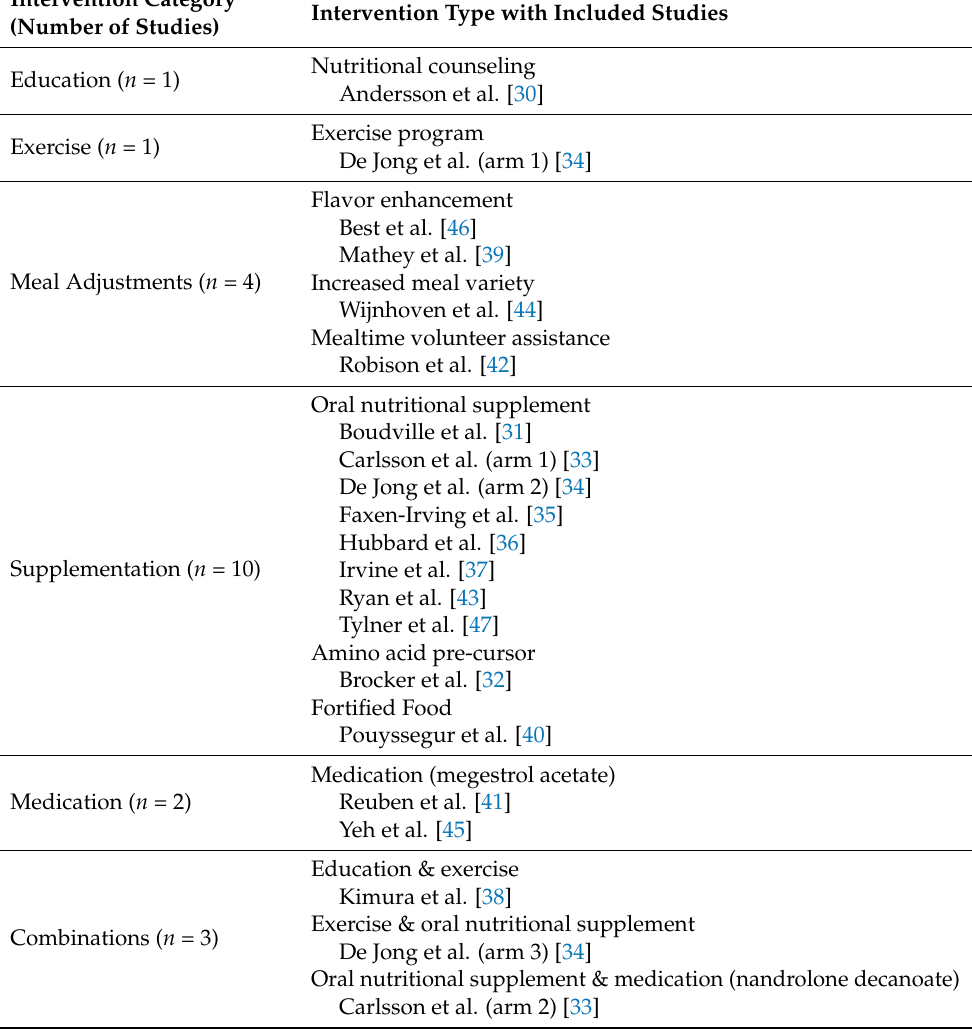
Table 1. Categorization of types of intervention for anorexia of aging with included